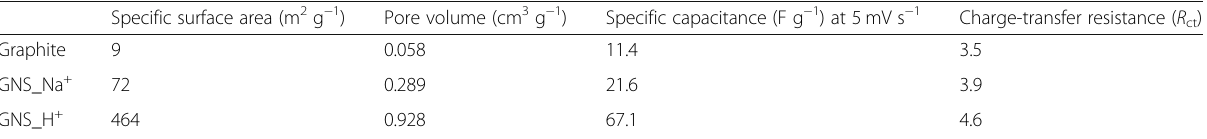
Table 1 Specific surface areas, pore volumes, specific capacitances, and charge transfer resistances of graphite, GNS_Na + , and GNS_H